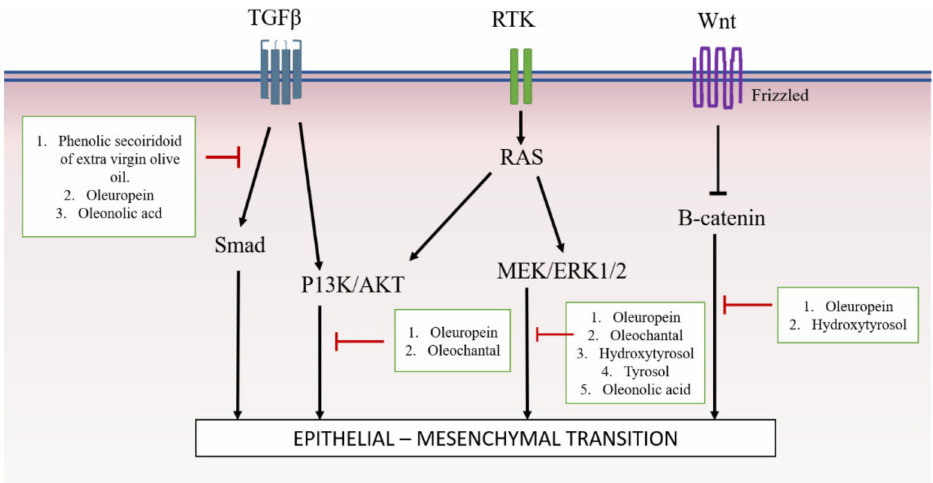
Figure 2. Summary of Olea europaea extract and its active compounds’ mechanism of action on signaling pathway of